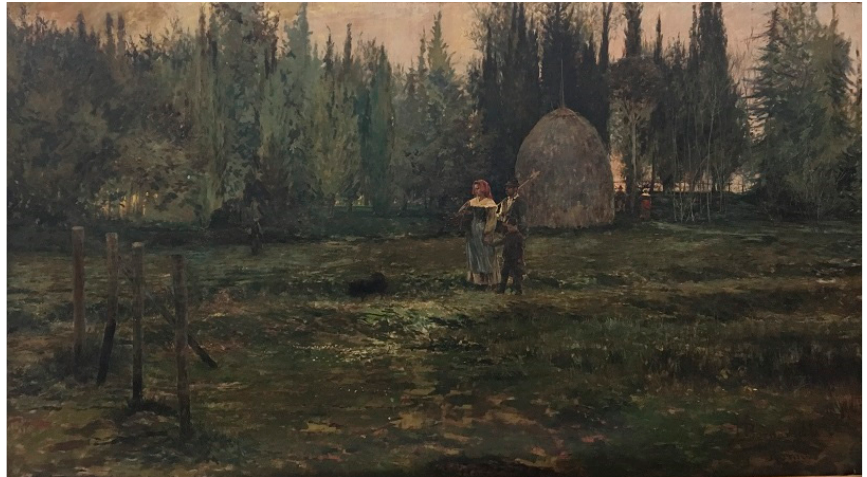
Figure 3. Henrique Bernadelli, “ Volta do trabalho ”, 1878–1886, dimensions (170 cm × 300 cm), National Museum of Fine Arts/collection, Rio de Janeiro.